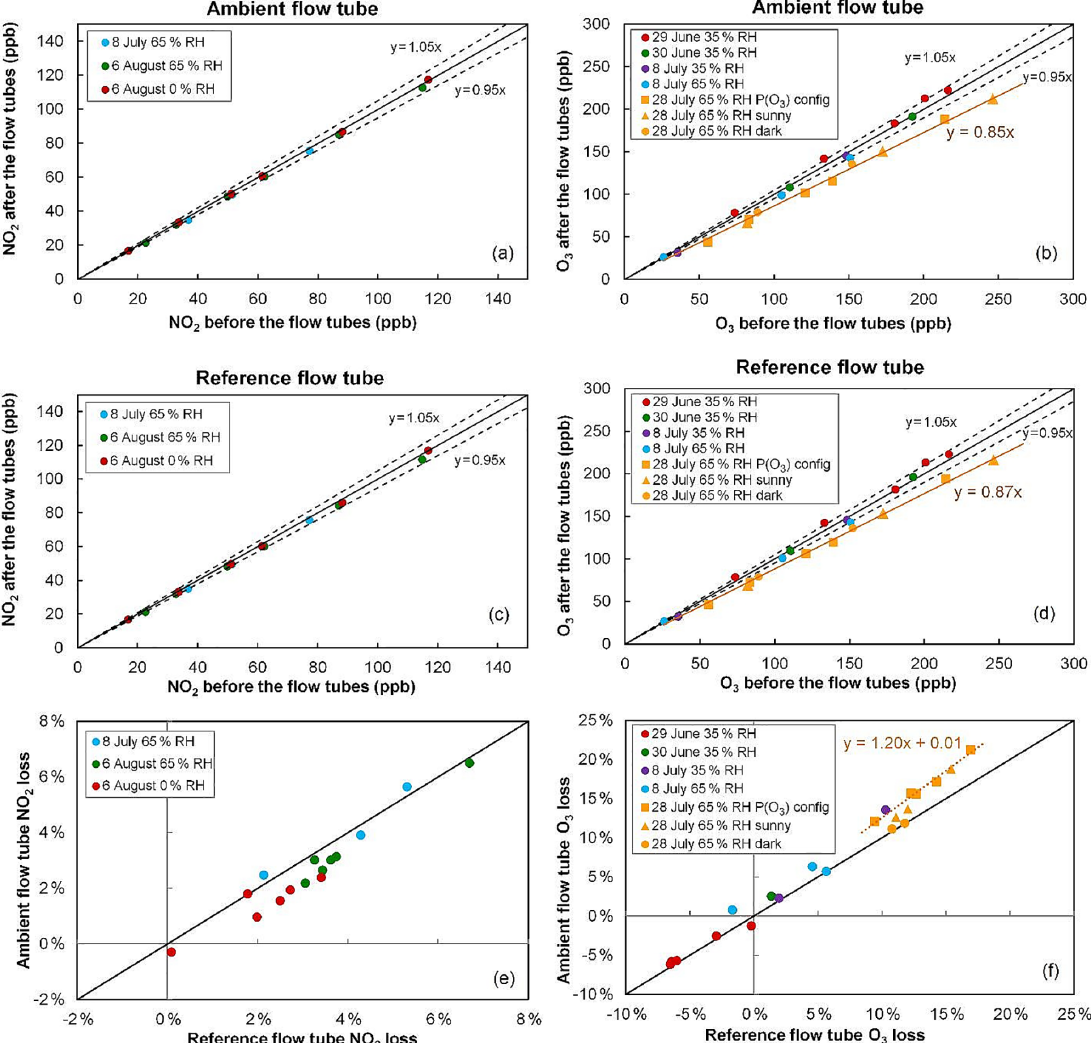
Figure 3. NO 2 and O 3 relative losses measured during the IRRONIC field campaign at different relative humidity values. Losses in the ambient and reference flow tubes are shown in the top and middle panels, respectively. The bottom panel reports the difference in relative losses between the two flow tubes. On 28 July O 3 losses were measured under sunny conditions (orange squares: ambient flow irradiated and reference flow tube covered by the UV filter; orange triangles: both flow tubes irradiated) and dark conditions (orange circles: both flow tubes covered by an opaque